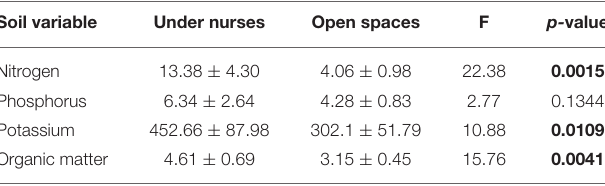
TABLE 3 | Soil nutrients available (nitrogen mg/Kg, Phosphorus mg/Kg, potassium mg/Kg) and organic matter (%) under nurses and in open spaces.